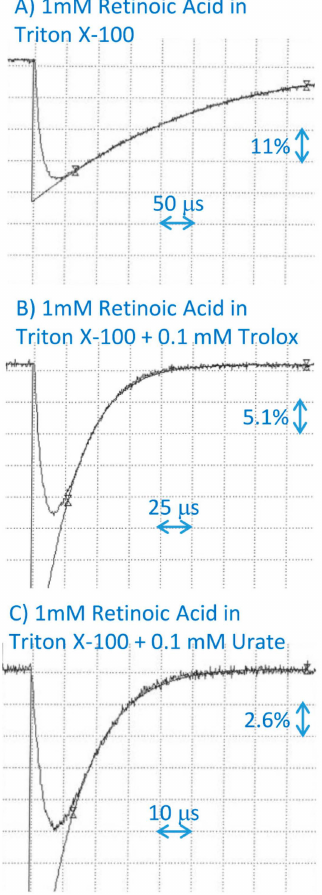
Figure 4. Representative kinetics of the formation and decay of retinoic acid cation radicals monitored at 590 nm after pulse radiolysis of aqueous solution saturated with N 2 O and containing 10 mM of phosphate, pH 7, 0.1 M of KBr, and 1 mM of retinoic acid incorporated in 2% Triton X-100 micelles, in the absence ( A ) and presence of 0.1 mM of Trolox ( B ) or uric acid ( C